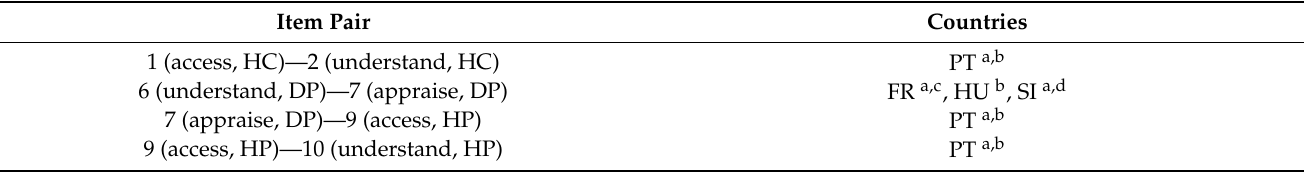
Table 9. Dependent item pairs.